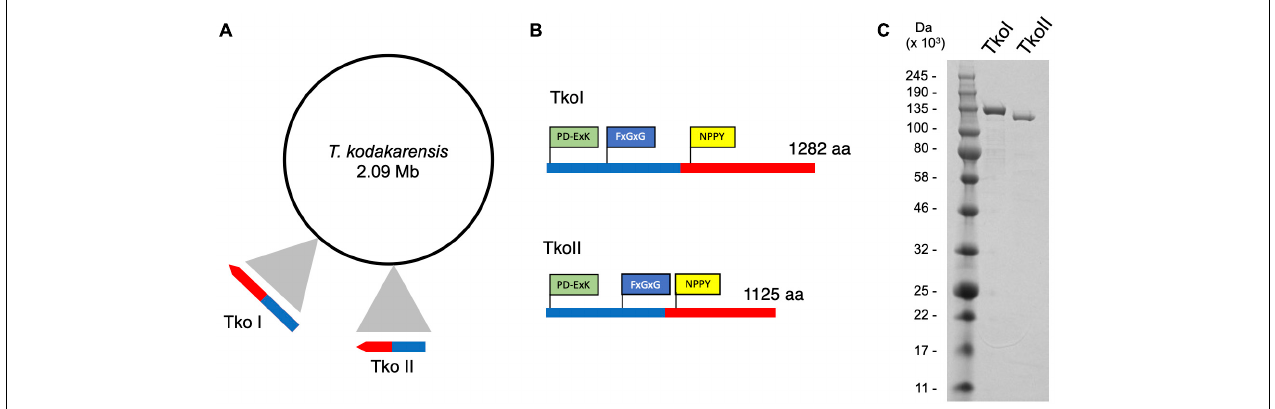
FIGURE 1 | Genomic organization of Thermococcus kodakarensis restriction-modification systems. (A) ORF TK1460 (1,285,915–1,289,763 nt) encodes TkoI and ORF TK1158 (1,017,279–1,020,656 nt) encodes TkoII endonuclease-methyltransferase fusion proteins. (B) TkoI (1,282 aa) and TkoII (1,125 aa) contain a conserved endonuclease motif PD-ExK (green) and FxGxG and NPPY methyltransferase motifs (blue and yellow, respectively). (C) SDS-PAGE of purified TkoI and TkoII demonstrate the recombinant proteins are thermo-tolerant, easily purified and > 95%